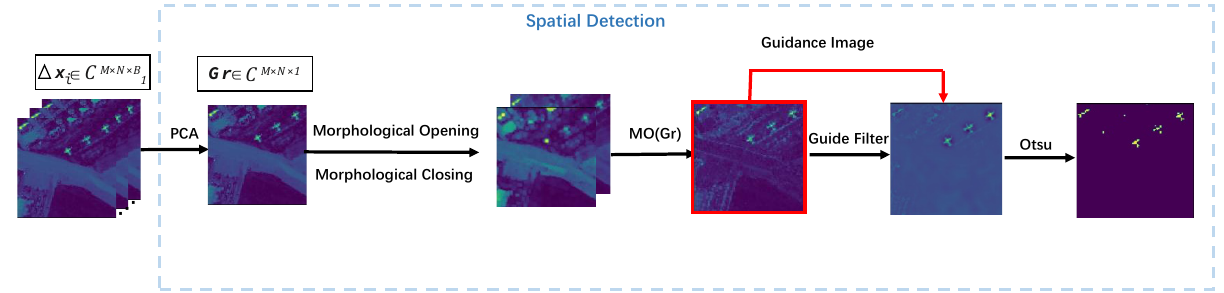
Figure 4. The specific architecture of spatial